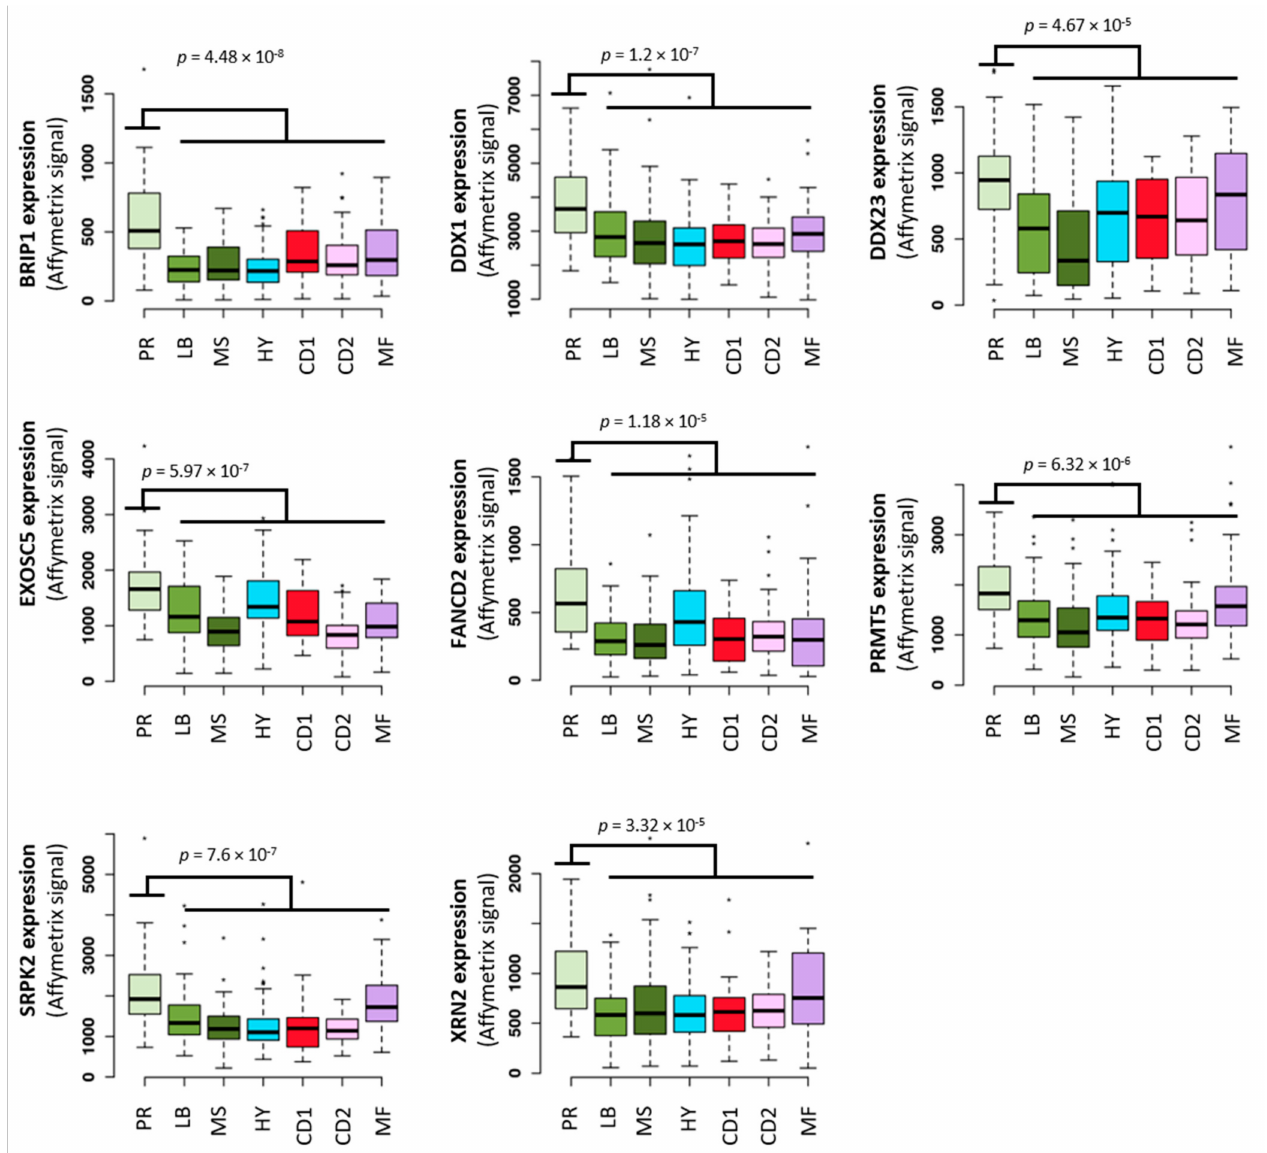
Figure 5. 8 TRCs resolution genes are significantly overexpressed in the proliferation molecular subgroup in MM. Expression of 8 TRCs resolution genes in patients of the 7 MM molecular subgroups of the TT2 cohort (Arkansas, newly diagnosed MM patients treated by High dose therapy (HDT) and autologous stem cell transplantation (ASCT), n = 345). Affymetrix microarrays expression box-plots were defined using GenomicScape web tool (http://www.genomicscape.com accessed on 23 July 2021. PR = proliferation, LB = low bone disease, MS = MMSET, HY = hyperdiploid, CD1 = cyclin D1 and cyclin D3, CD2 = cyclin D2 and cyclin D3, MF = MAF. Statistical difference was assayed using Student’s t -test. * p ≤ 0.05, ** p ≤ 0.01, *** p ≤